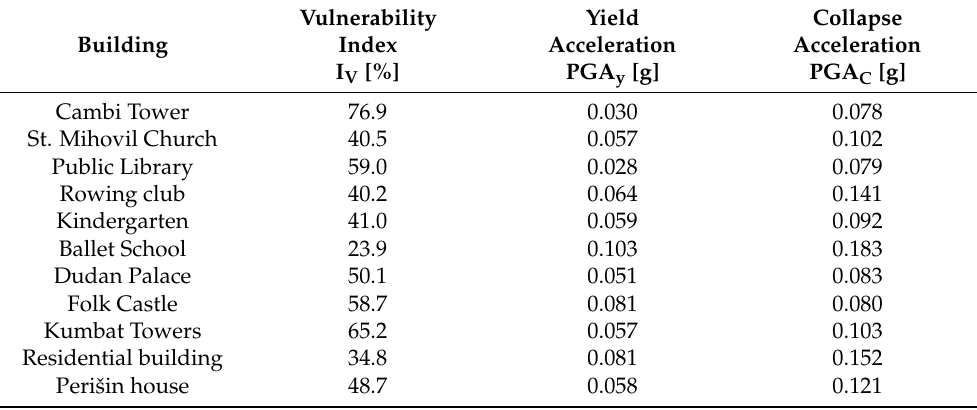
Figure 15. Analyzed buildings: ( a ) Cambi Tower; ( b ) St. Mihovil Church; ( c ) Public Library; ( d ) Rowing club; ( e ) Kinder- garten; ( f ) Ballet School; ( g ) Dudan Palace; ( h ) Folk Castle; ( i ) Kumbat Towers; ( j ) Residential building—Obala kralja Tomislava 1; ( k ) Perišin house. Table 3. Vulnerability index, yield acceleration, and collapse acceleration of the